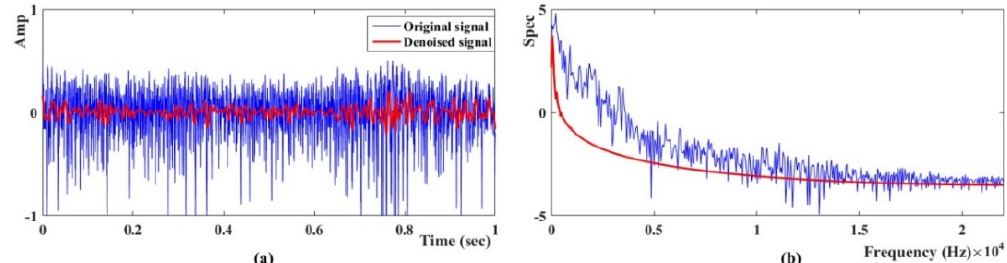
Figure 12. ( a ) The amplitude of the original and the denoised signal; ( b ) the frequency spectrum of the original and the denoised signal.